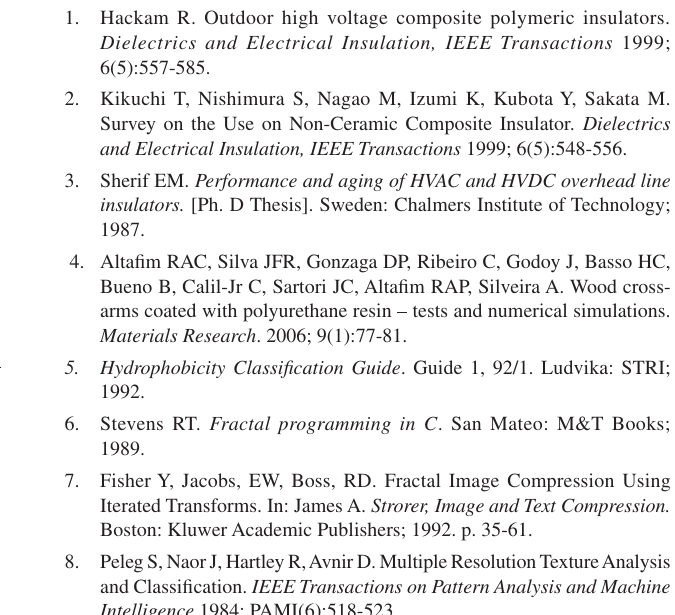
Figure 6. df values of various %AIA